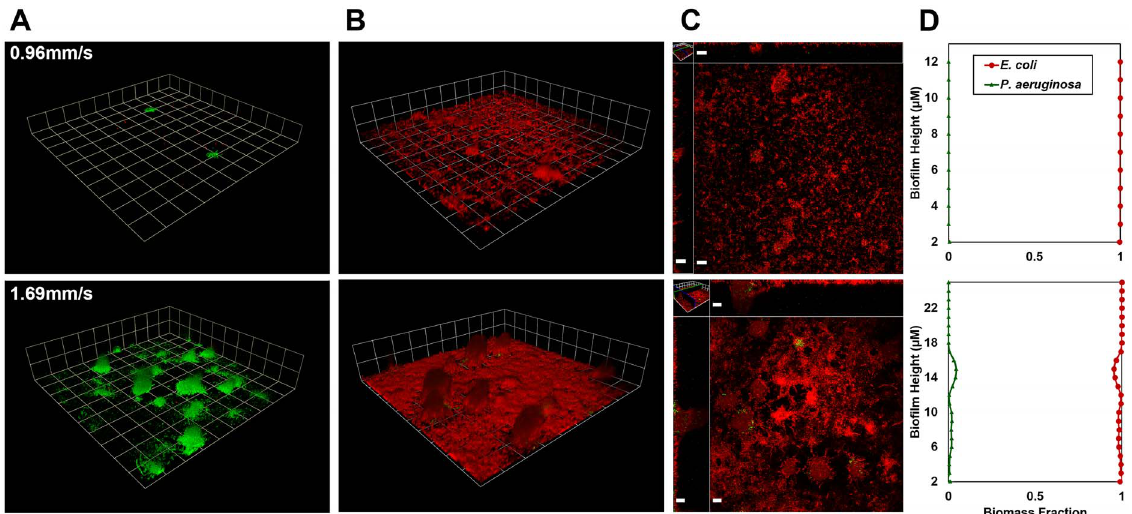
Figure 5. Colonization of P.aeruginosa biofilms by E.coli under a controlled flow gradient in a planar flow cell and in R2A medium. E. coli appears red and P. aeruginosa appears green. Results are presented for two local fluid velocities, 0.96 mm/s (top row) and 1.69 mm/s (bottom row). Column A) E. coli deposited on 3-day old P. aeruginosa biofilms (grid unit is 23.8 m m). B) Mixed P. aerugiosa and E. coli biofilms on day 6, 3 days after E. coli inoculation (grid unit in B is 23.8 m m). C) Horizontal section near the base of the biofilm and vertical sections of the biofilm shown in panel B (scale bar=15 m m). D) Distribution of P. aerugiosa and E. coli biomass as function of height, indicating that E. coli was the dominant species throughout the biofilm. E. coli appears red and P. aeruginosa -GFP appears green.